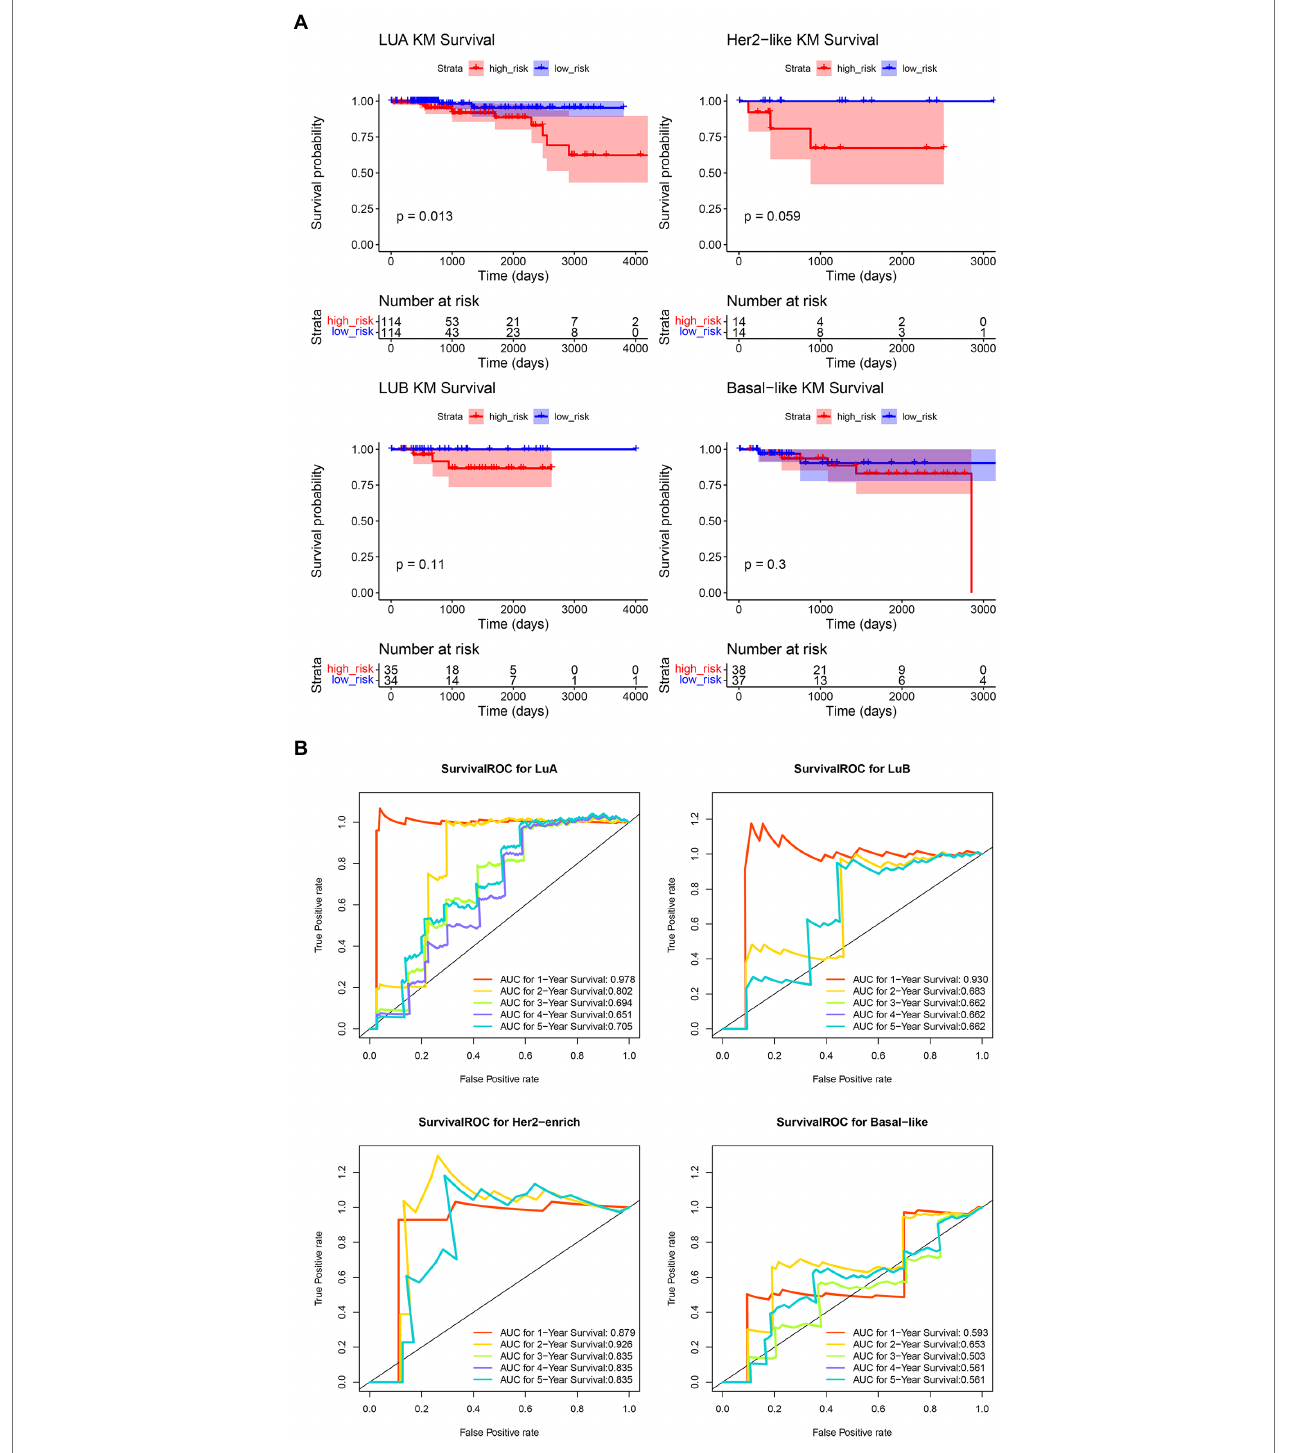
FIGURE 6 | Evaluation of COAGULATION-related gene signature in the four molecular subtypes of IDC. (A) The K-M curves of high-risk groups and low-risk groups in the four molecular subtypes of IDC. (B) The AUC of ROC curves in predicting 1-, 2-, 3-, 4-, and 5-year